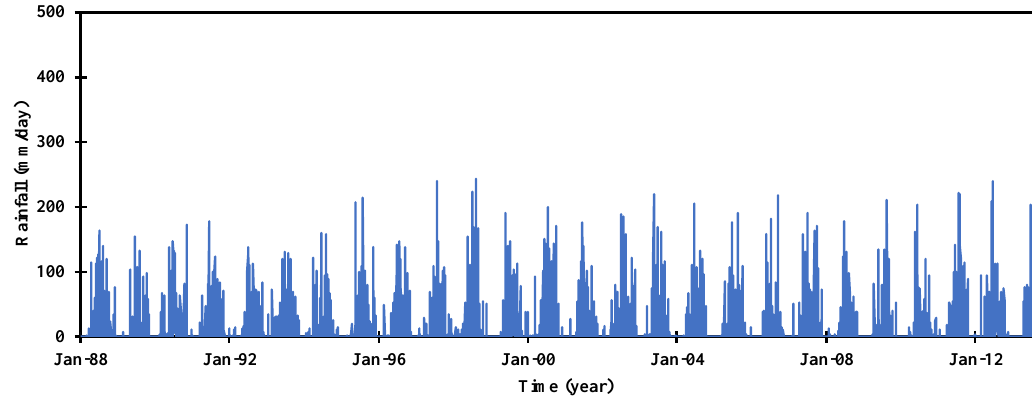
Figure 5. Distribution of daily rainfall at Cox’s Bazar station during 1988–2013 from BMD.